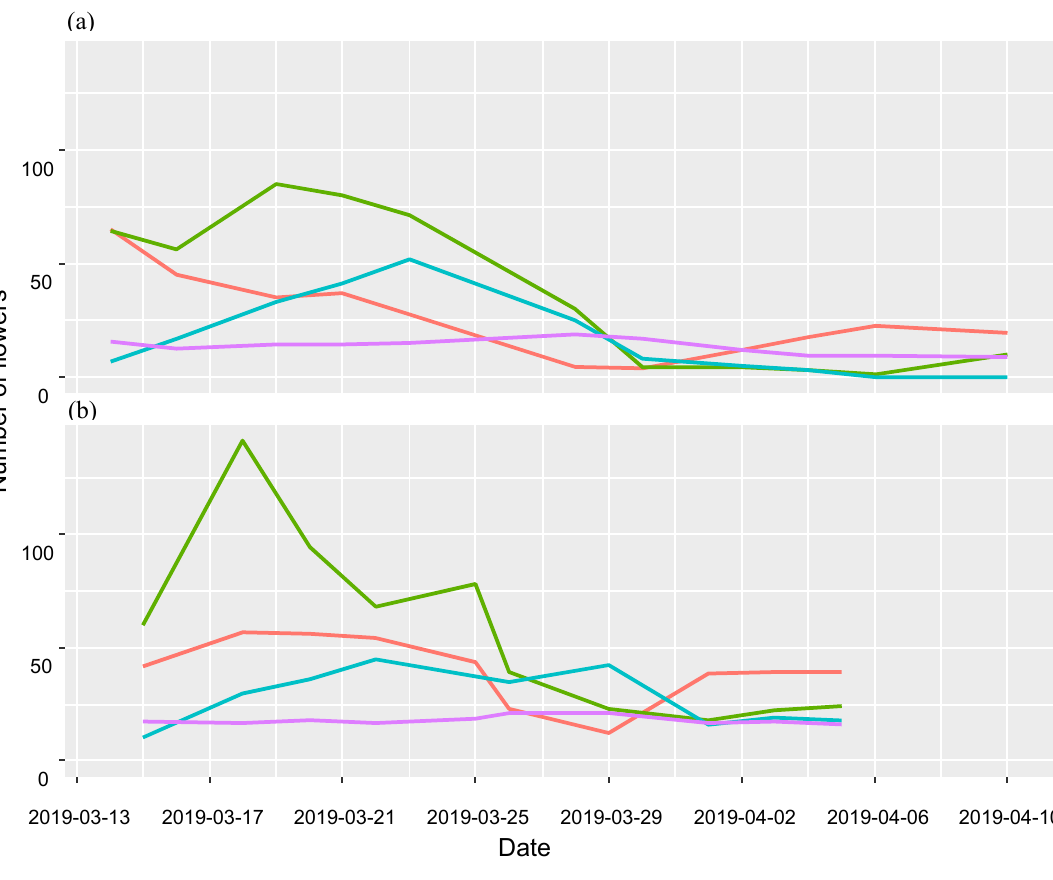
Figure A1. Number of flowers of each species of the experimental exotic plant communities at each day of observation in ( a ) the urban context and ( b ) the natural context. For Duranta erecta (pink) and Cuphea hyssopifolia (purple), the actual number of flowers was divided by ten to fit the scale of Clerodendrum ugandense (green) and Osteospermum sp. (blue).